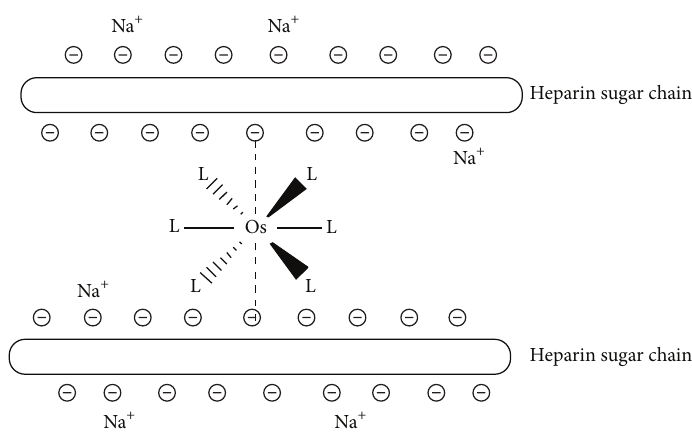
Figure 6: Schematic drawing of the interaction of heparin with the double positive-charged osmium complexes.